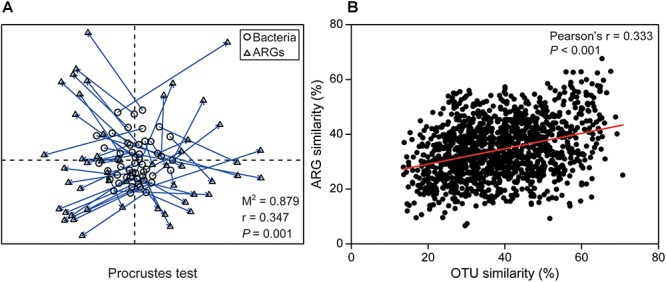
The relationships between bacterial community and ARG profiles. (A) Procrustes test of the significant correlation between ARG composition and bacterial community composition based on Bray-Curtis similarity metrics (M2 = 0.879, r = 0.347, P = 0.001, 999 permutations). (B) The significant but weak correlation between bacterial taxonomic community similarity and ARG profiles similarity.